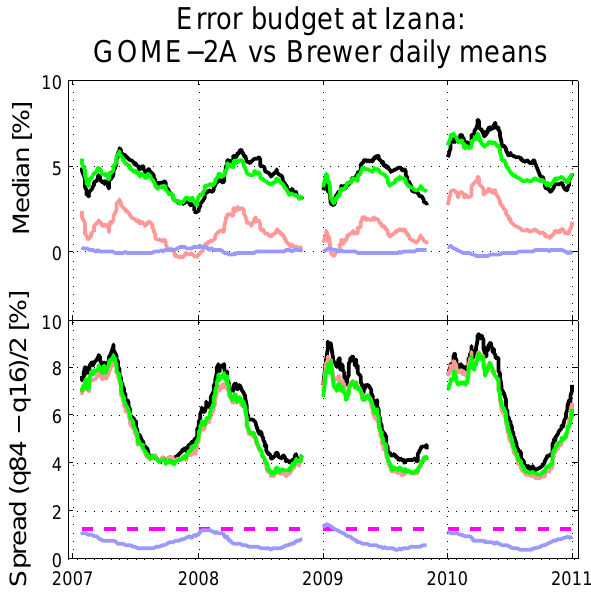
Figure 10. Error budget of 4years of GOME-2A vs. Brewer com- parisons at Izaña using a very relaxed spatial co-location criterium of 1000km maximum distance. Colours as in Fig.